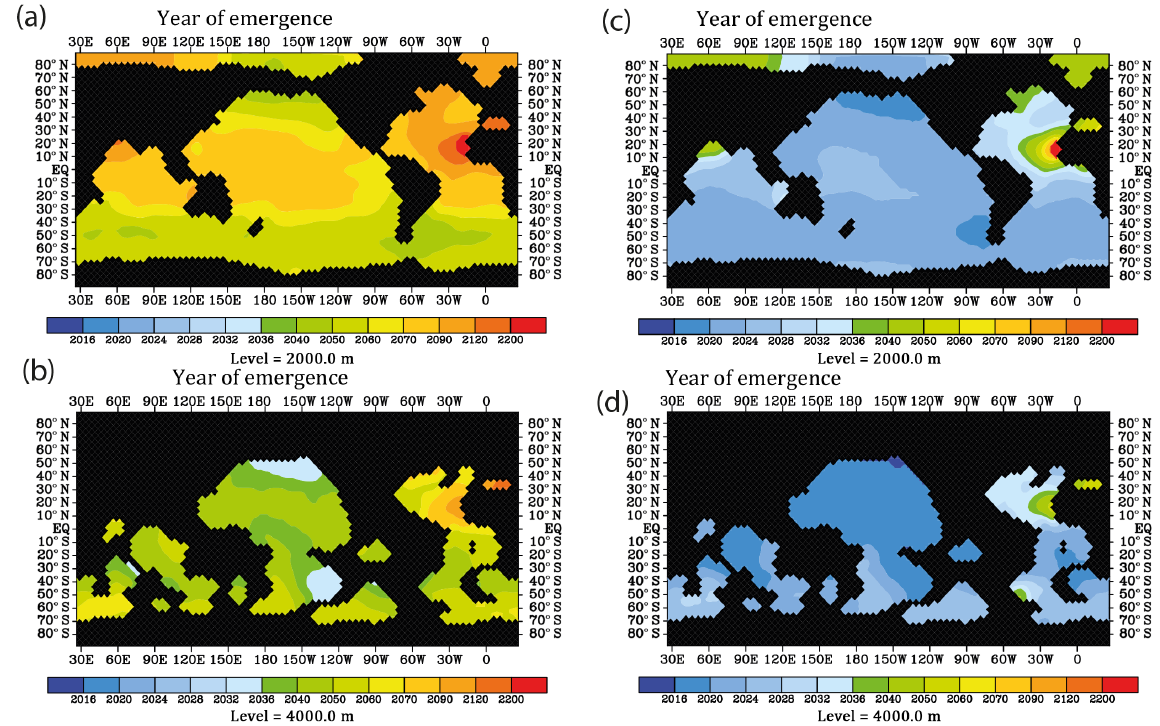
Figure 10. Prospective year of emergence for an ocean-acidification-induced signal in dissolved 230 Th activity as derived from the model runs. Shown are the calendar years of emergence for the depth levels at 2000 and 4000m. All figures are shown for the strong RCP8.5 scenario concerning atmospheric CO 2 concentration and the moderate scenario of calcification decrease with saturation state, with the year 2010 as a reference year for 230 Th activity and 0.075dpm/1000L as analytical threshold between different samples. (a) For the moderate calcification scenario, at 2000m depth. (b) Same as panel (a) but for depth level 4000m. (c) For the extreme calcification scenario, at 2000m depth. (d) Same as panel (c) but for depth level